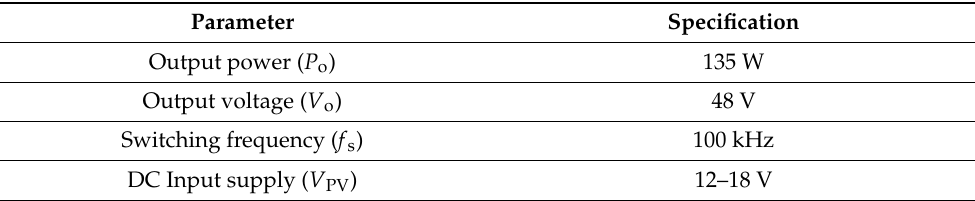
Table 1. Specifications of the